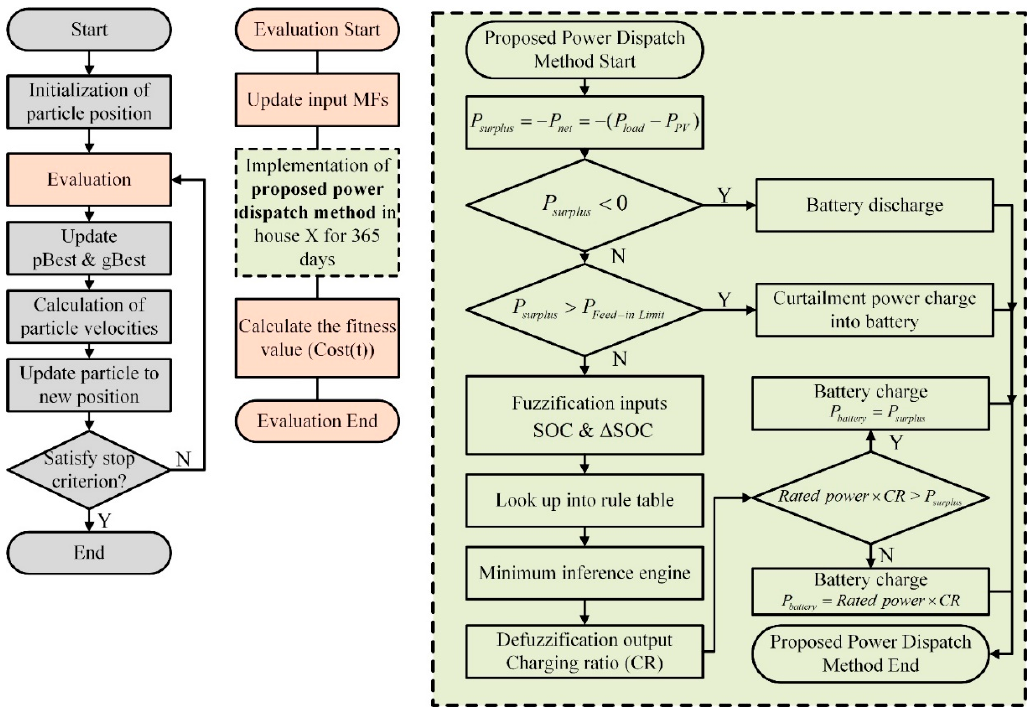
Figure 8. Optimization flowchart.